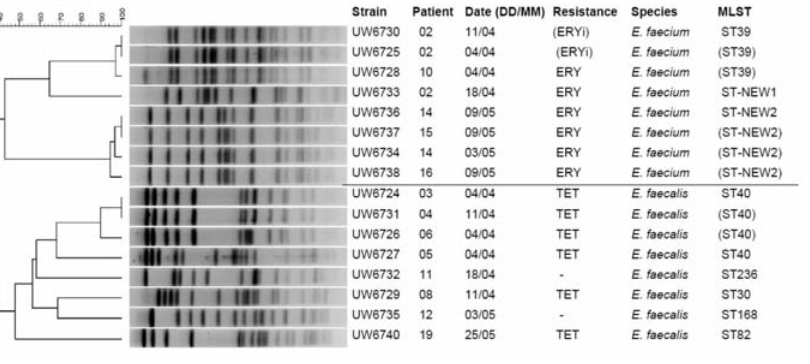
Figure 1. Sma I macrorestriction patterns in Pulsed-Field Gel Electrophoresis (PFGE) of all enterococcal isolates colonizing neonatal patients. Clusters of related isolates from samples of different neonates suggest horizontal transmission between patients (clonal spread), for instance, isolates E. faecalis UW6724 [Patient no. 3], UW6731 [Patient no. 4], and UW6726 [Patient no. 6]. MLST types in parentheses are predicted according to an identical PFGE profile. Profiles ST-NEW1 and ST-NEW2 are new MLST types due to new (N) allele sequences which have the following allelic profiles: ST-NEW1 [N-8-8-N- 6-27-6]; ST-NEW2 [25-8-N-17-10-N-6] (see also http://efaecium.mlst.net/ and http://efaecalis.mlst.net/). ERY(i), erythromycin (intermediate); TET, tetracycline; MLST, Multi-locus sequence typing; ST, sequence type (of MLST); n.d., not